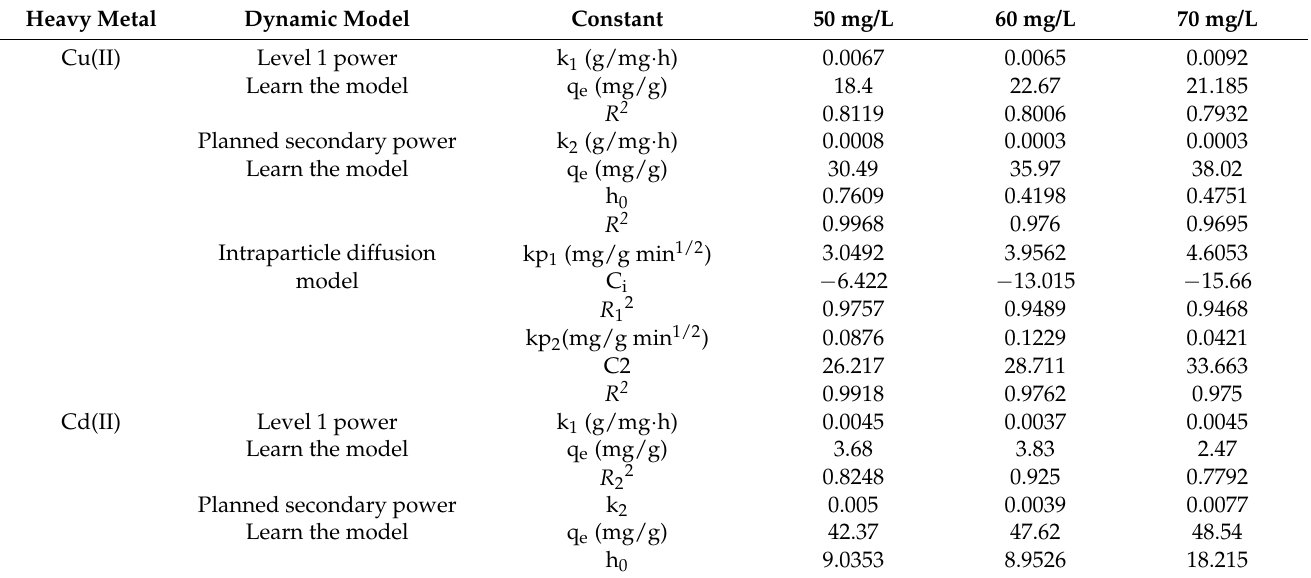
Table 6. Fitted data of the kinetic models on optimally modified bamboo charcoal adsorbing different concentrations of Cu(II)/Cd(II)